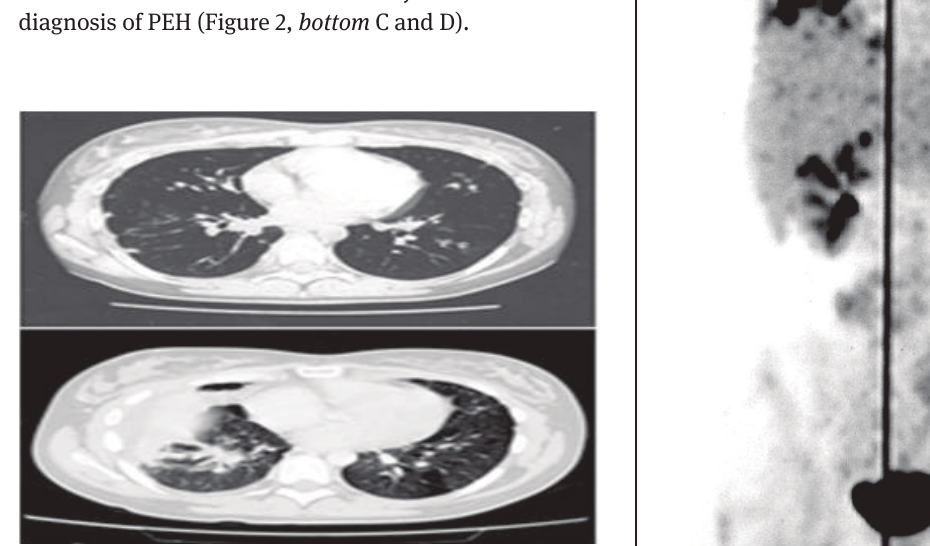
Figure 3: 18-FDG-PET showing abnormal accumulation throughout the right middle and lower lobe, and in mediastinal lymph nodes, in the left iliac crest (arrow) and in a left rib